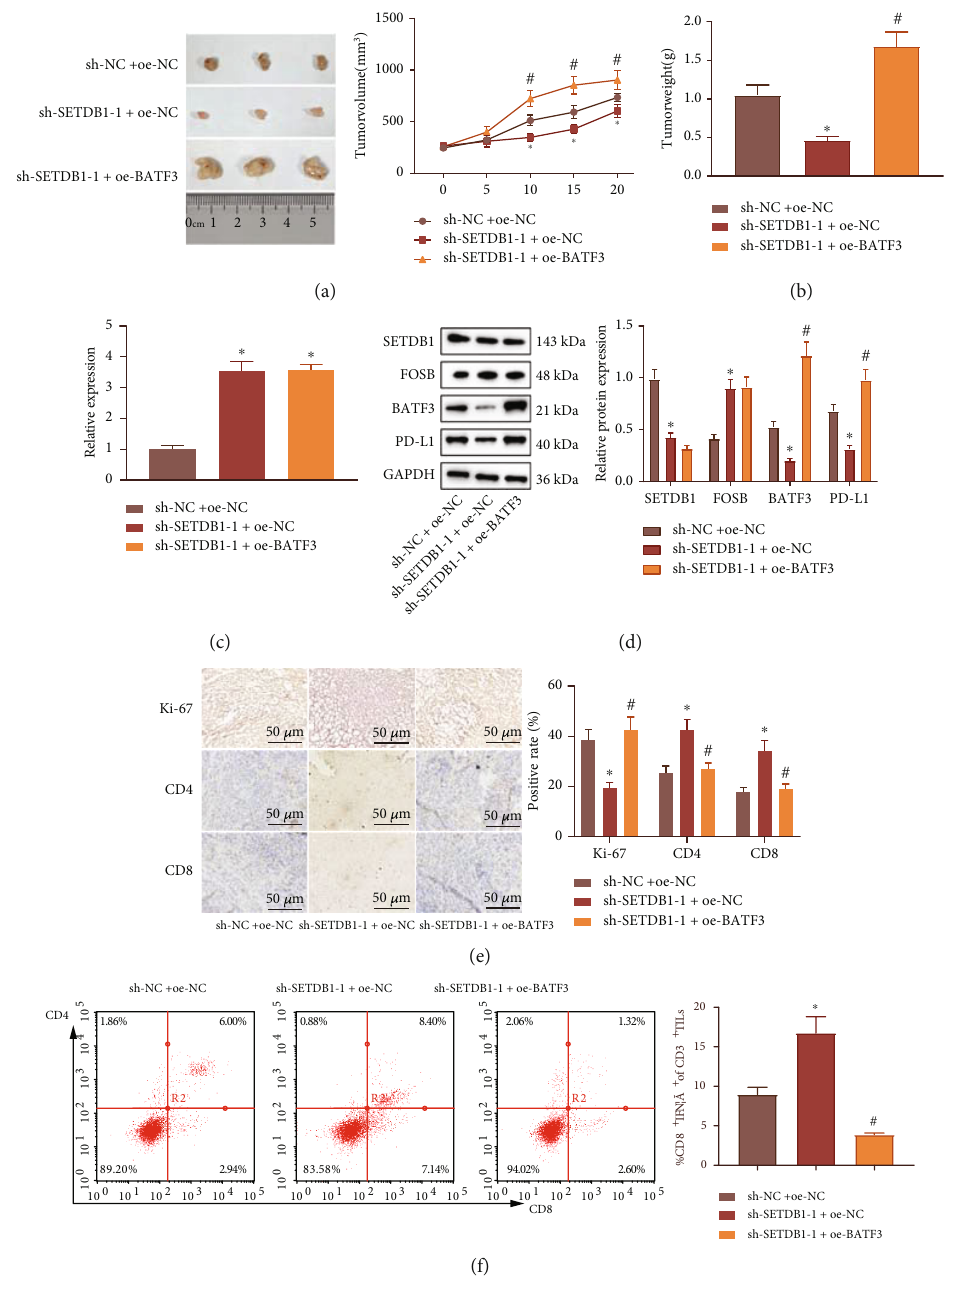
Figure 5: Downregulation of SETDB1 represses CRC tumor growth and immune cell in fi ltration in mice via the FOSB/miR-22/BATF3/PD- L1 axis. (a) Tumor volume in nude mice after di ff erent treatments. (b) Tumor weight in nude mice after di ff erent treatments. (c) miR-22 expression in tumor tissues of nude mice determined by RT-qPCR. (d) The protein expression of SETDB1, FOSB, BATF3, and PD-L1 in tumor tissues of nude mice normalized to GAPDH determined by Western blot analysis. (e) The expression of Ki-67, CD4, and CD8 in tumor tissues of nude mice determined by IHC, scale bar: 50 μ m. (f) Percentage of CD8 + and IFN- γ + in tumor tissues of nude mice analyzed by fl ow cytometry. ∗ p < 0 : 05 vs. nude mice bearing cells treated with sh-NC+OE-NC. # p < 0 : 05 vs. nude mice bearing cells treated with sh-SETDB1+OE-NC. n = 10